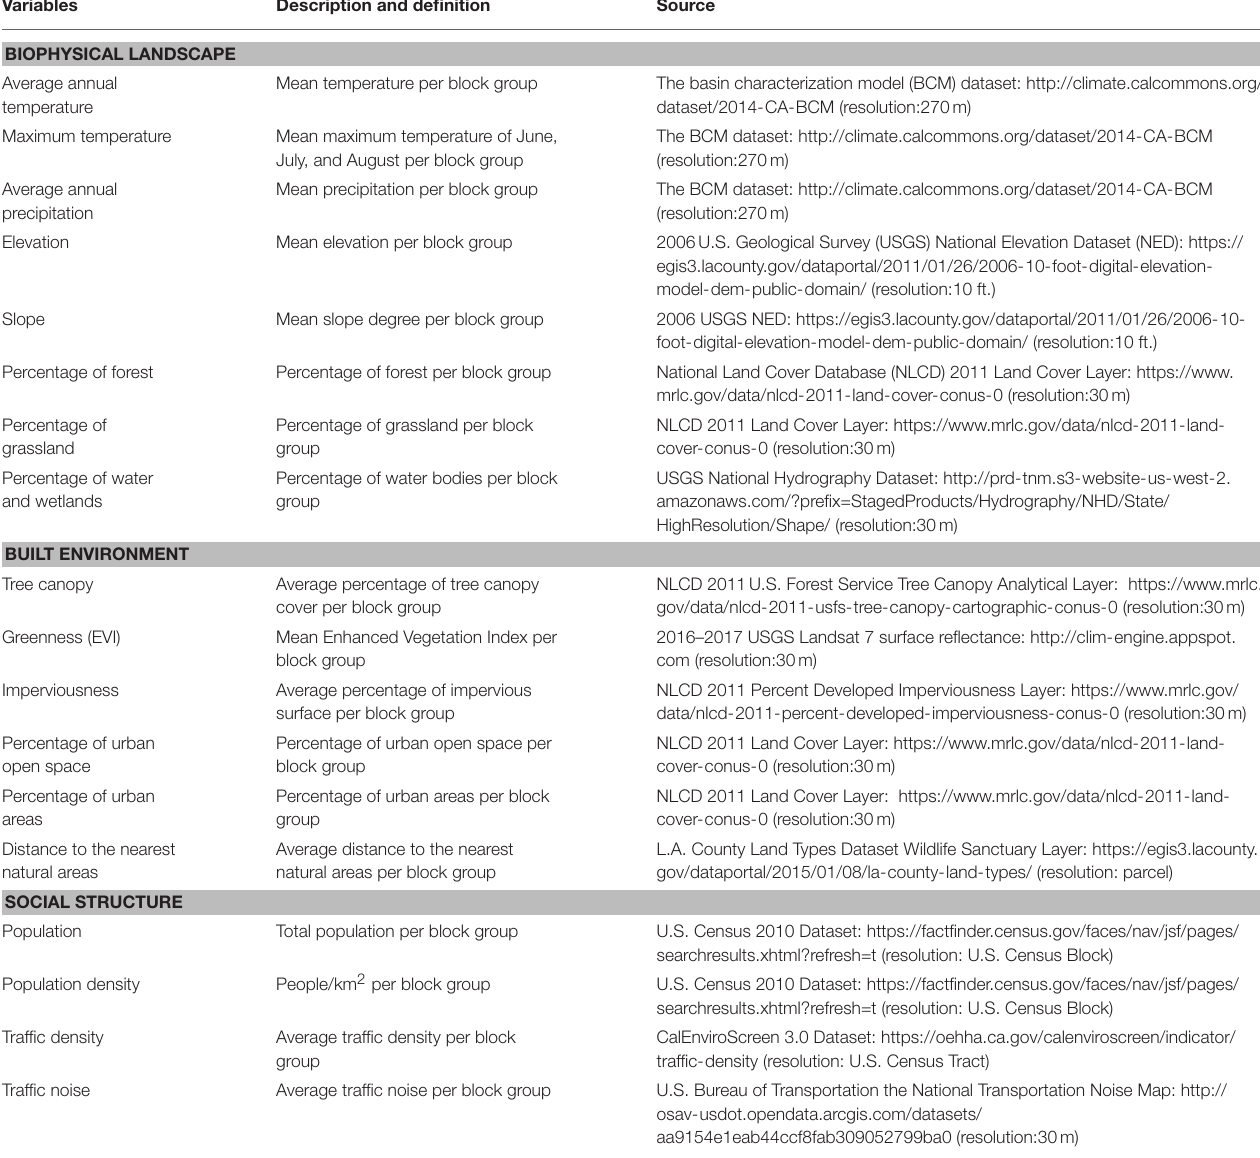
TABLE 1 | List of variables used in the BAILA urban typology classification